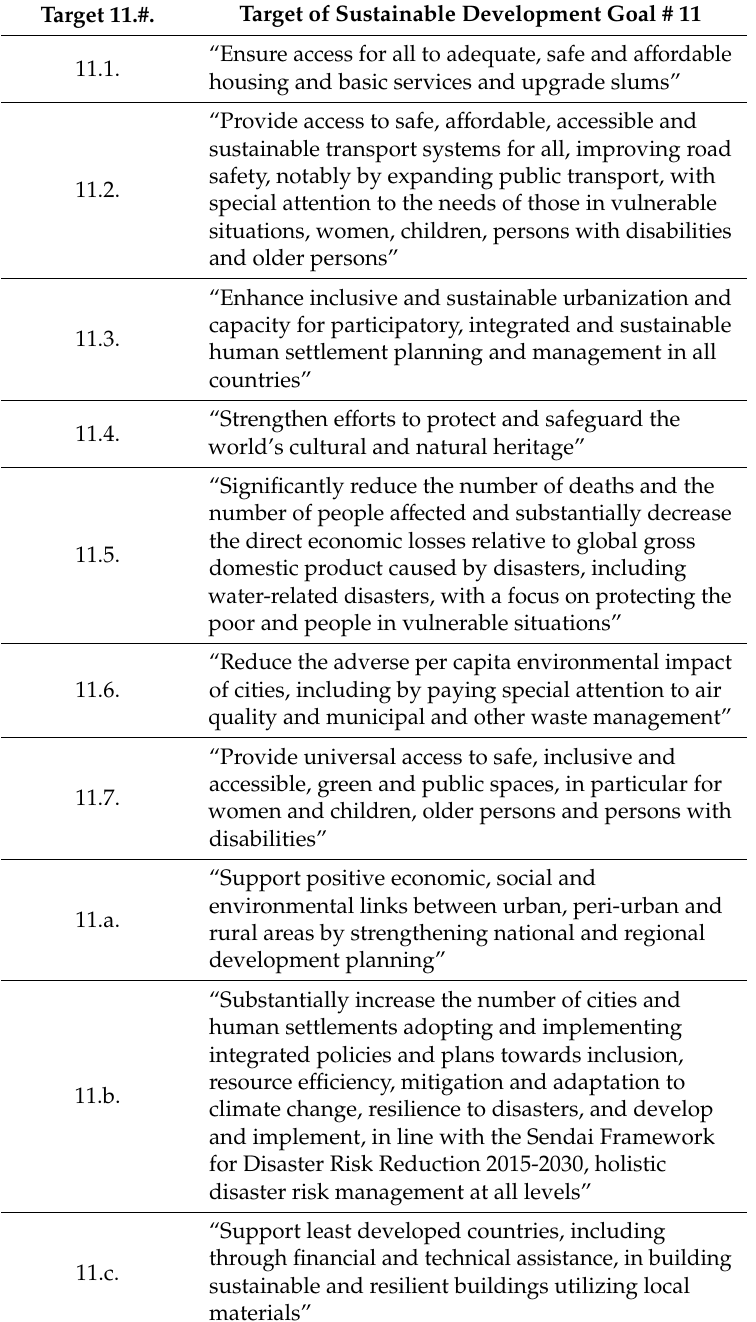
Table 4. Description of the targets included in Sustainable Development Goal # 11 [3]. Target